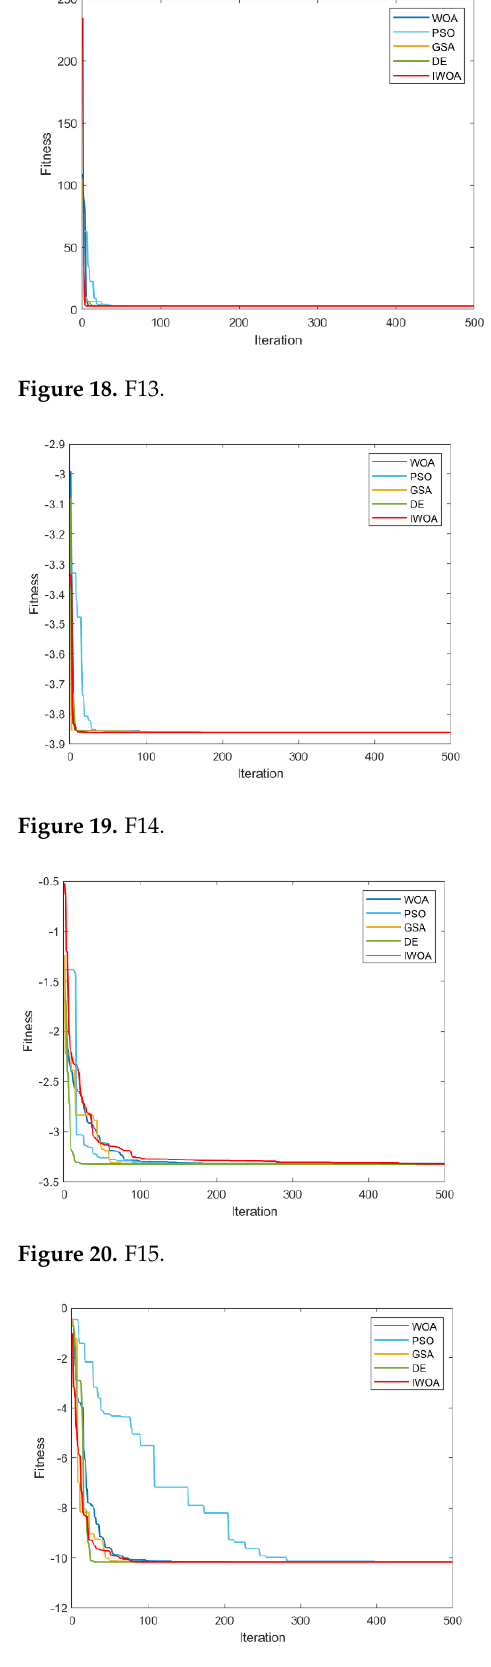
Figure 21. F16. Figure 21. Figure 21. F16.